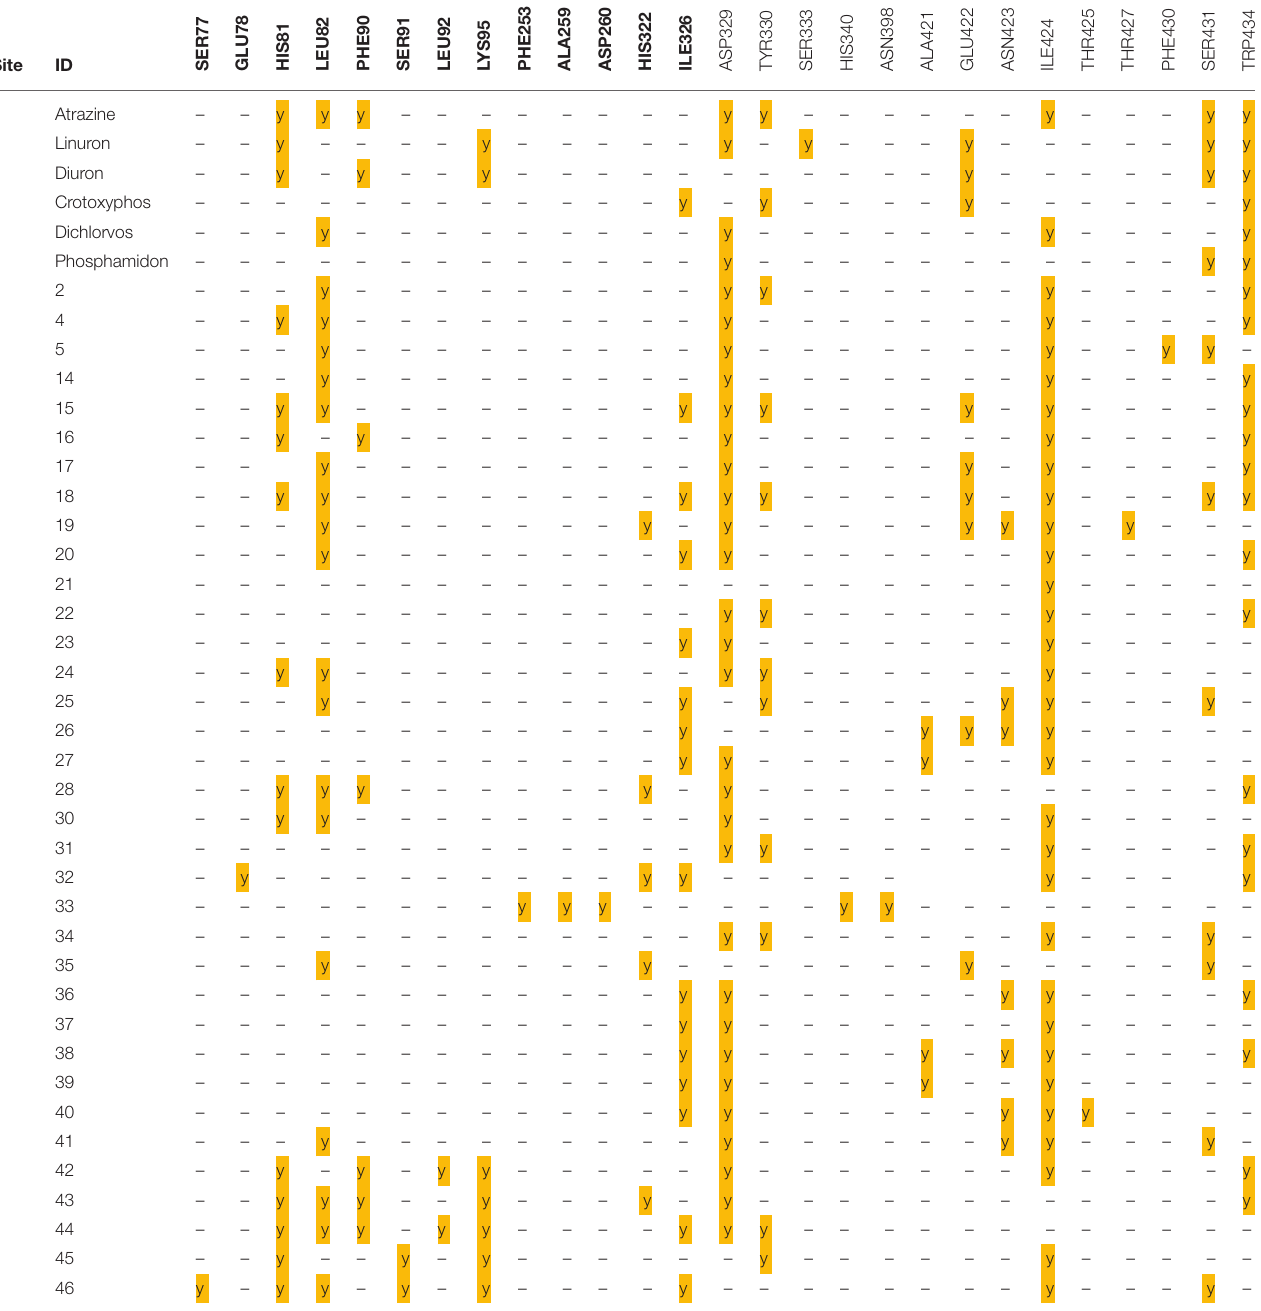
TABLE 8 | Binding modes residues data for each ligand studied.